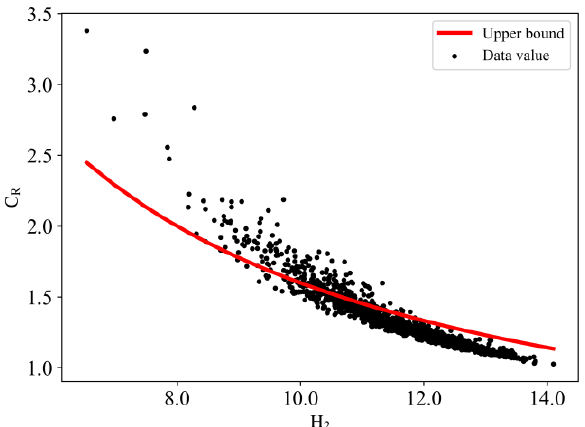
Figure 15 The upper bound by H 2 and scatter plot of H 2 against C R obtained by JPEG-LS